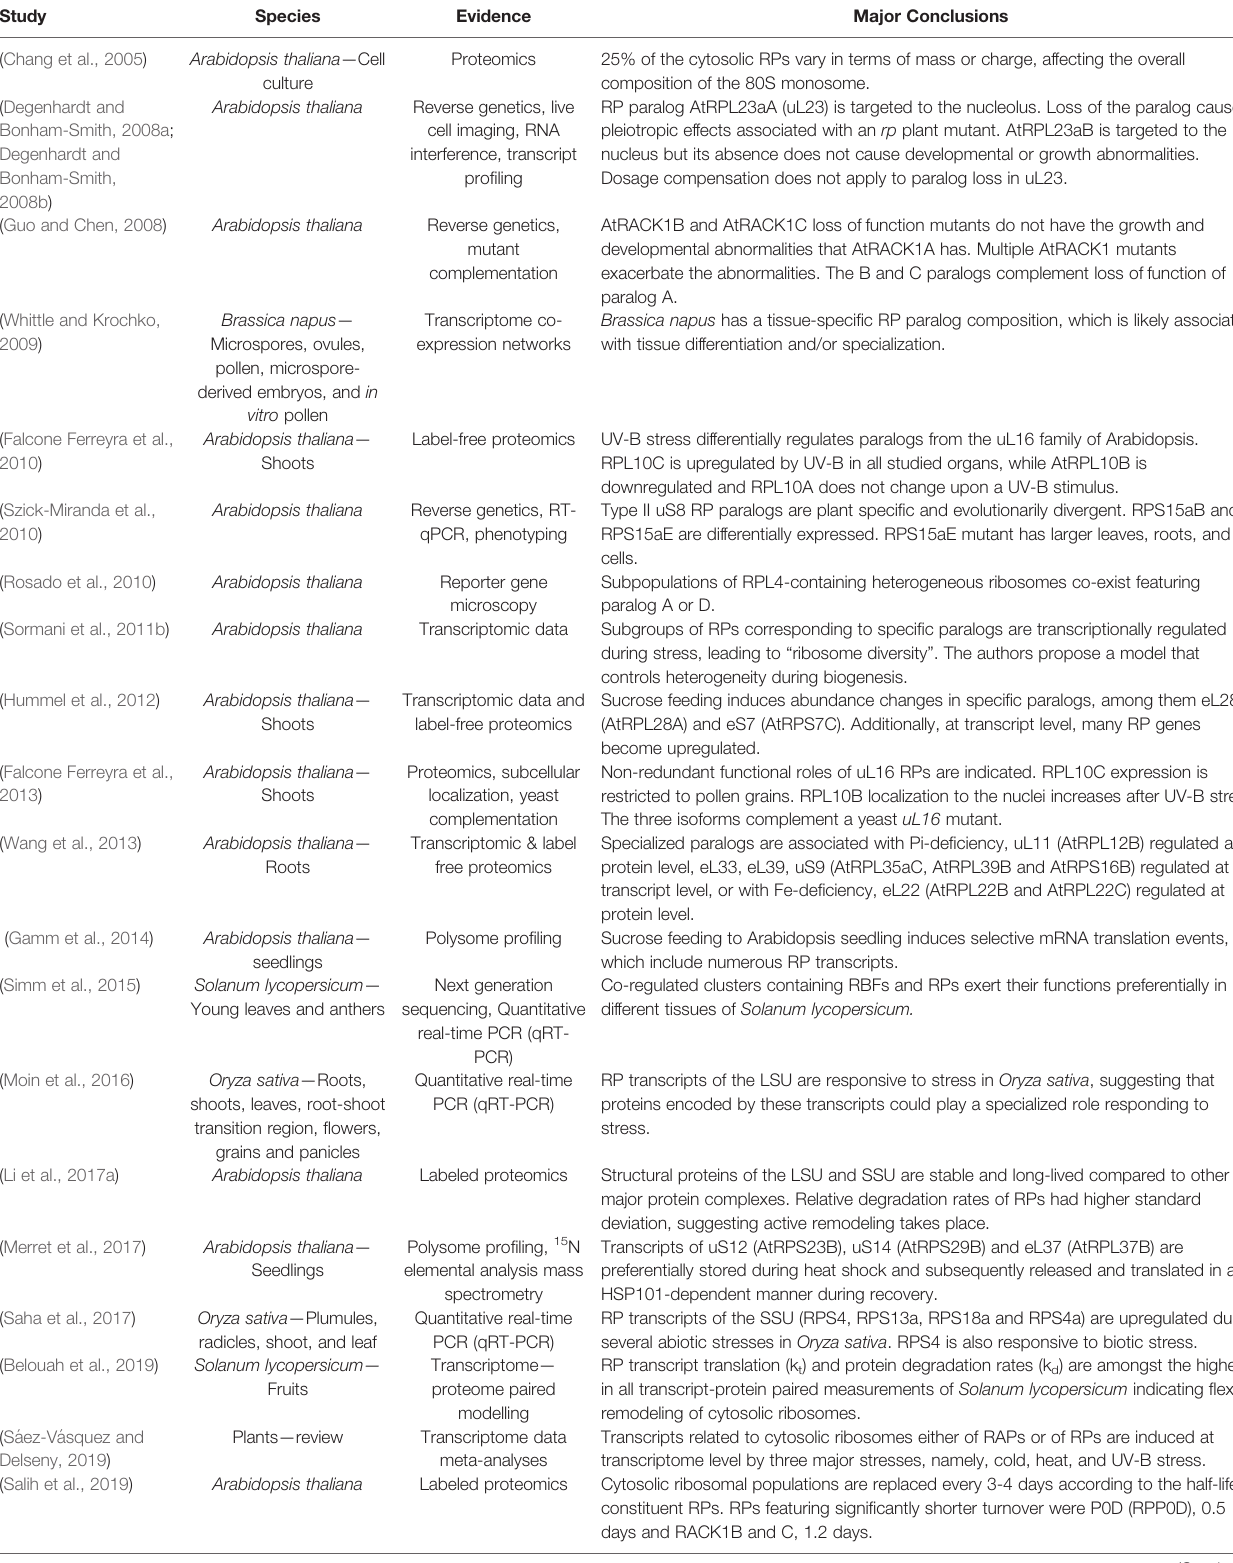
TABLE 1 | Plant studies with supporting evidence for and major conclusions regarding cytosolic ribosome heterogeneity and specialization in chronological